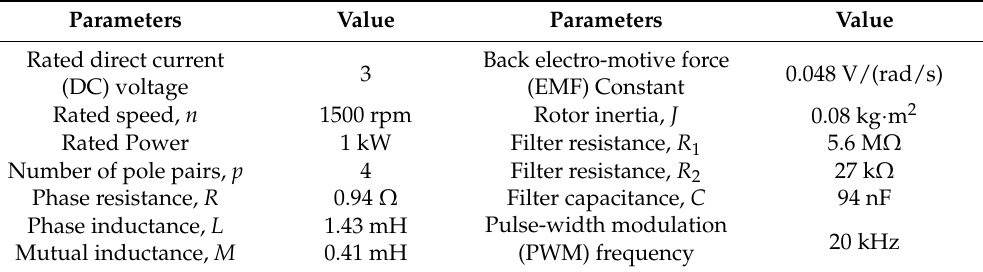
Table 5. Motor parameters.